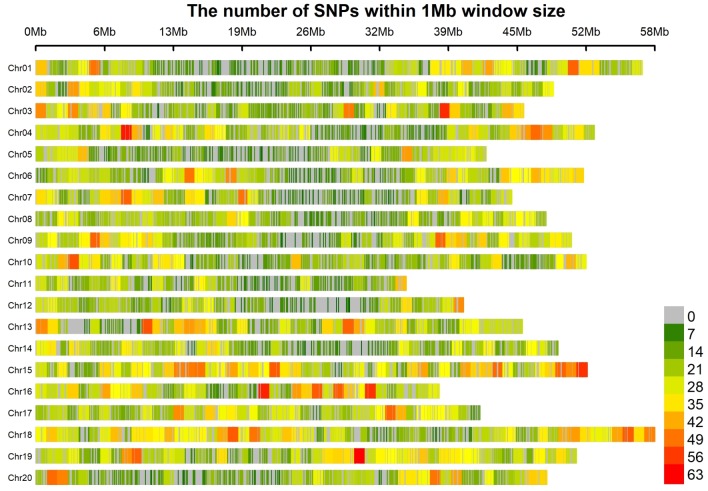
SNP density and distribution across the 20 soybean chromosomes.